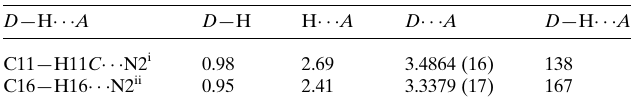
Table 6 Hydrogen-bond geometry (A˚ , (cid:3) ) for 1c .